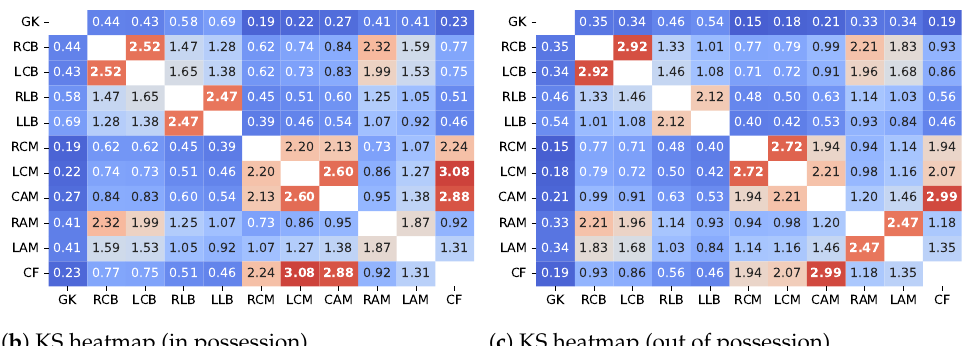
( a ) Violin plots (in/out of possession).